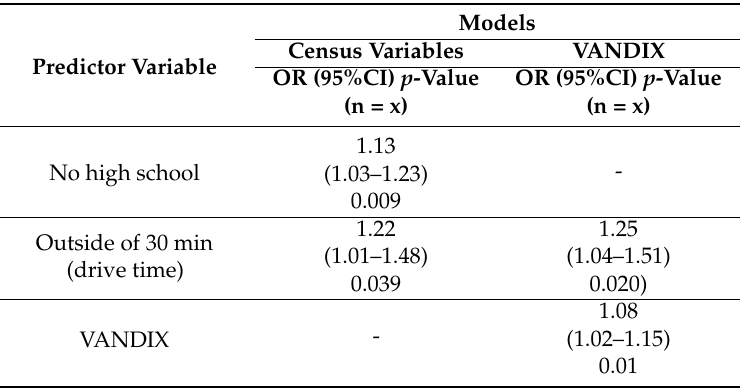
Table 4. Shows the final negative binomial model for both the VANDIX and the census variables.